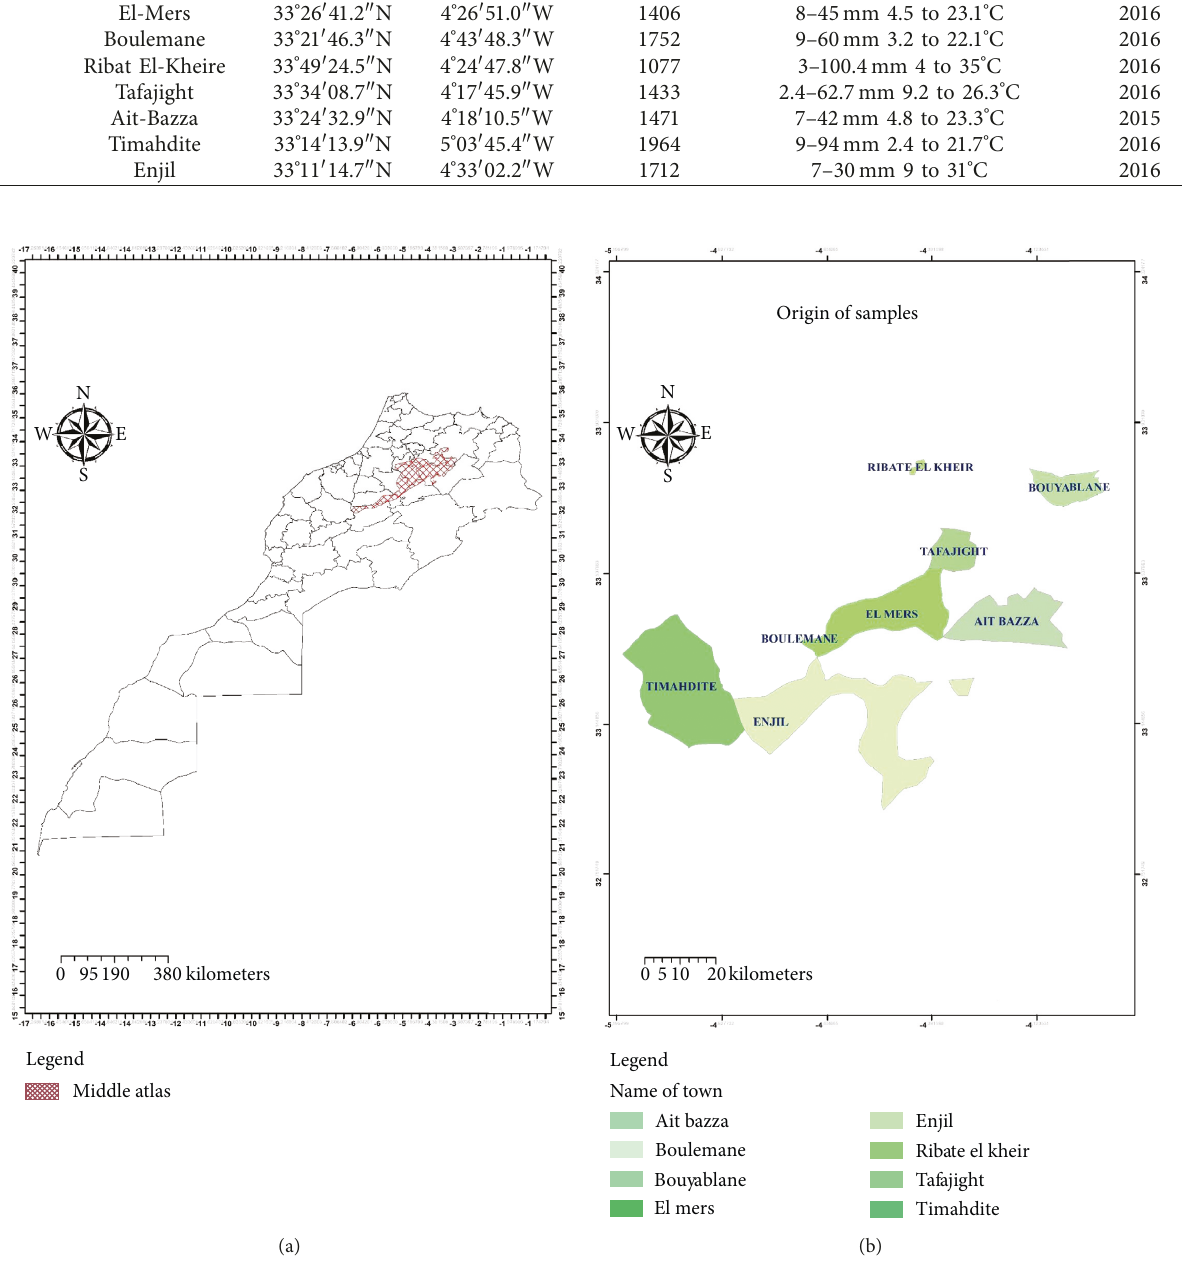
Figure 1: Map of Morocco showing honey sample regions in the middle